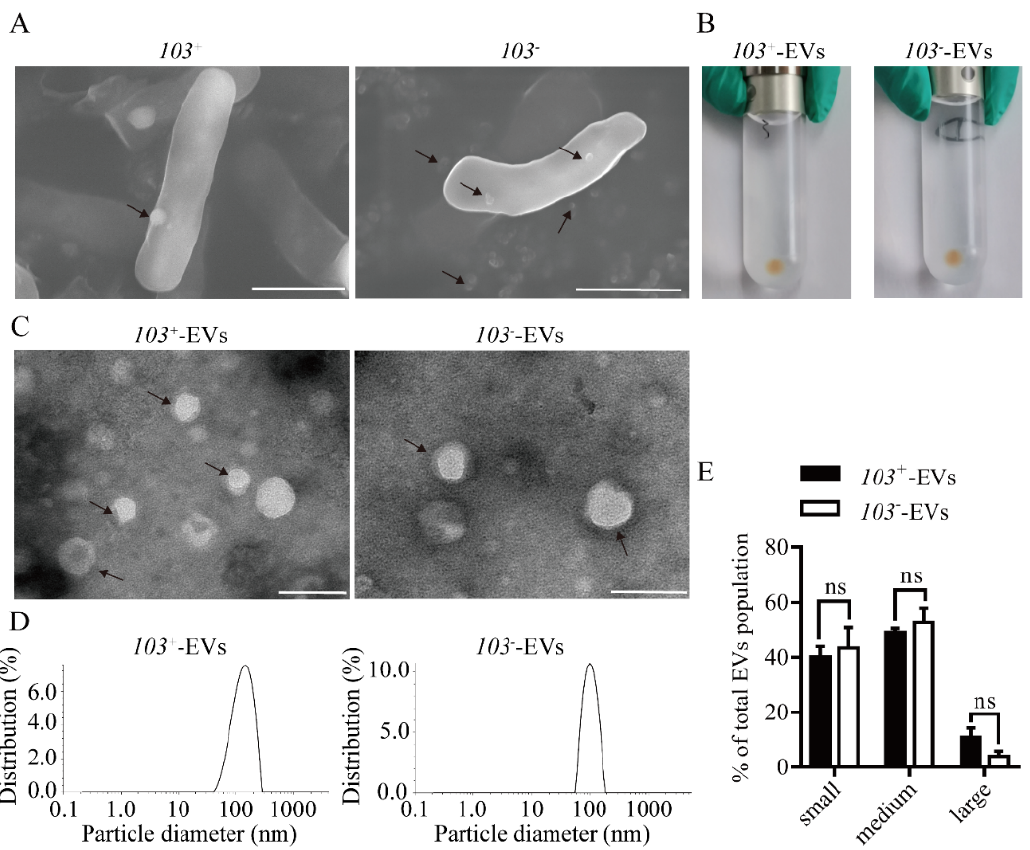
Figure 1. Characterization of extracellular vesicles (EVs) isolated from strains of R. equi 103 + ( 103 + ) and R. equi 103 − ( 103 − ). ( A ) Scanning electron microscopy visualization of EVs production by strains of 103 + or 103 − . Black arrow indicates EVs. Scale bars 1 um. ( B ) EVs pellet by ultracentrifugation from strains 103 + ( 103 + ‐ EVs) or 103 − ( 103 − ‐ EVs). ( C ) 103 + ‐ EVs or 103 − ‐ EVs were visualized by negative staining transmission electron microscopy. Black arrow indicates EVs. Scale bars 100 nm. ( D ) Dy ‐ namic light scattering determination of size distribution for 103 + ‐ EVs or 103 − ‐ EVs, respectively. ( E ) Quantification by dynamic light scattering of the size distribution of small ( < 100 nm), medium (100– 200 nm) and large (>200 nm) EVs produced by strains of 103 + or 103 − , as indicated. The comparisons between groups were performed by one ‐ way ANOVA followed by Tukey’s test. ns, not significant.